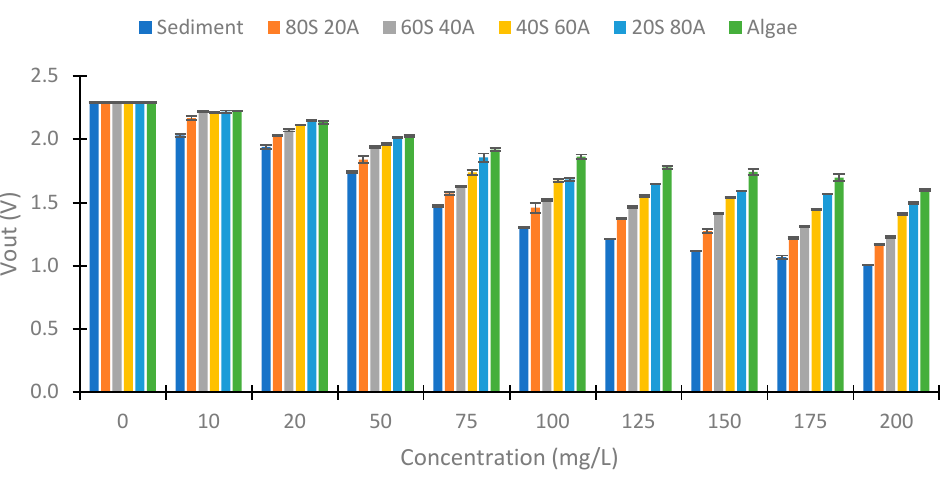
Figure 14. Vout with the use of blue light at voltage divider LDR at 180°.